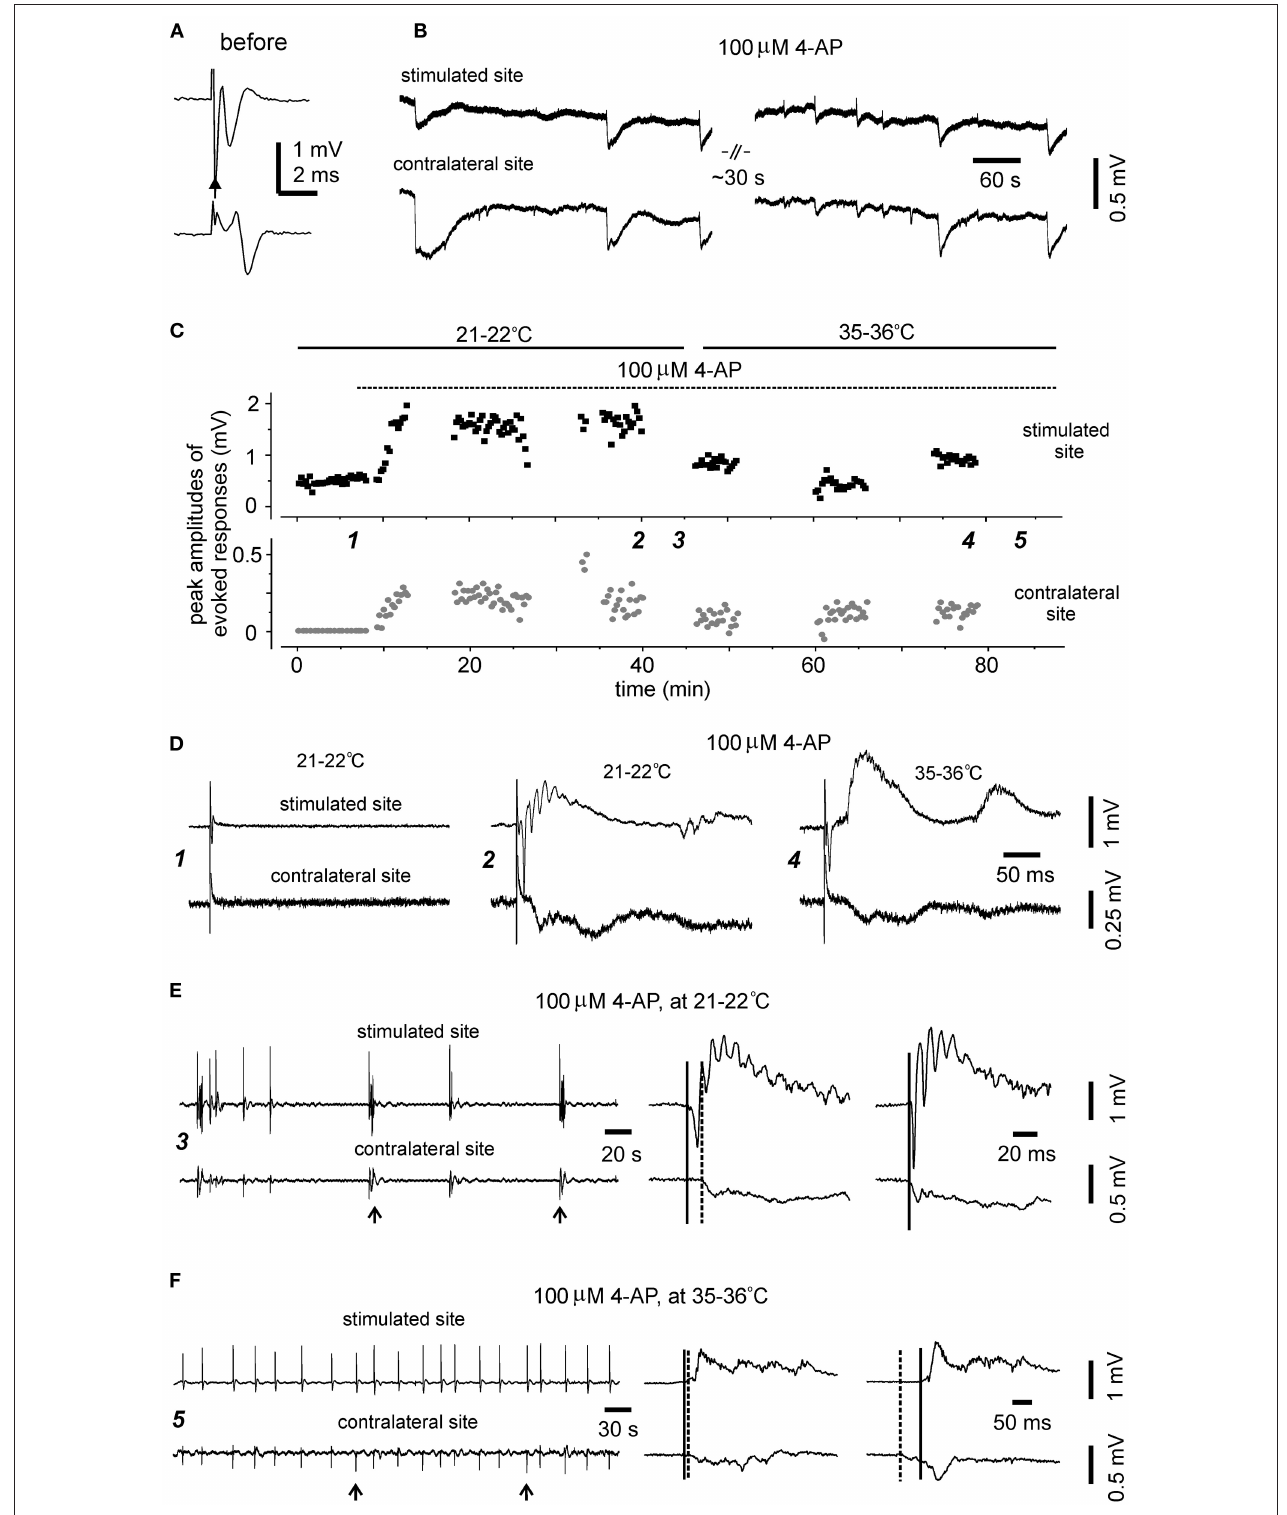
FIGURE 7 | Evoked and self-sustained responses observed from bilateral hippocampal slices of adult mice. (A,B) A slice obtained from a 9-month-old mouse. Recordings performed at the room temperature. Bilateral responses were evoked unilaterally (filled arrow) by constant stimulations at near maximal intensity (150 µ